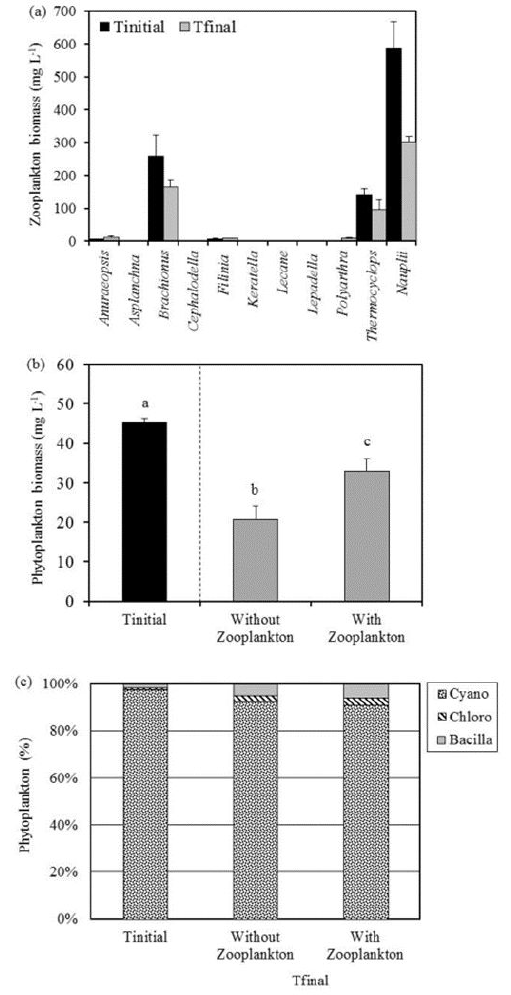
Figure 1. Zooplankton biomass (a), total phytoplankton Figure 2. Zooplankton biomass (a), total phytoplankton biomass (b), and relative biomass of phytoplankton classes (c) in experiments at Apipucos reservoir. T = Begin biomass (b), and relative biomass of phytoplankton classes Initial of experiment; T = End of experiment. Bars represent (c) in experiments at Mundaú reservoir. T = Begin Final Initial standard errors of the mean (±SEM). In Figure b, columns of experiment; T = End of experiment. Bars represent Final with the same letter do not differ significantly ( p < 0.05). standard errors of the mean (±SEM). In Figure b, columns Cyano = Cyanophyceae, Chloro = Chlorophyceae, with the same letter do not differ significantly ( p < 0.05). Bacilla = Bacillariophyceae, Eugle = Euglenophyceae, Cyano = Cyanophyceae, Bacilla = Bacillariophyceae, Crypto = Cryptophyceae. Chloro =